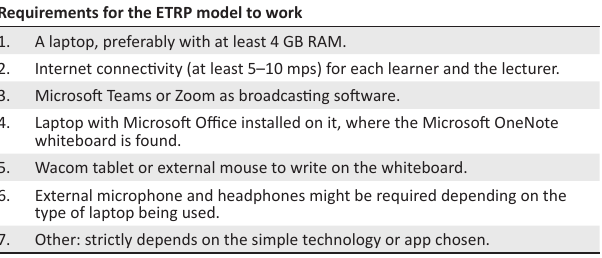
TABLE 1: Example of requirements needed to use Microsoft OneNote. Requirements for the ETRP model to work